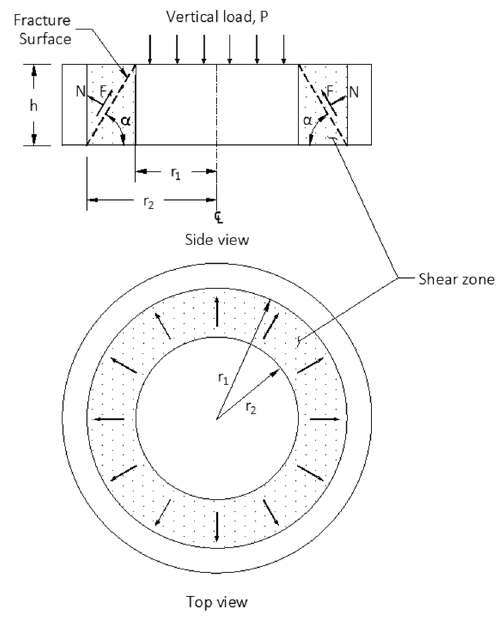
Figure 4. Schematic fracture surface at the ultimate load.